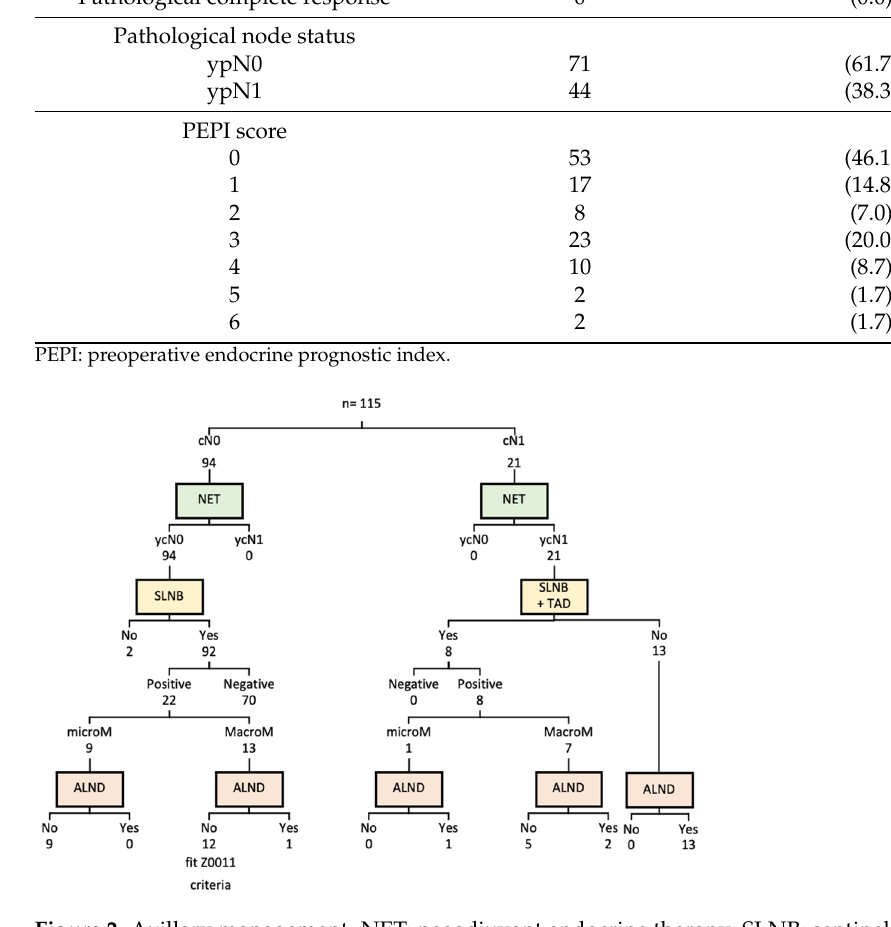
Figure 2. Axillary management. NET: neoadjuvant endocrine therapy; SLNB: sentinel lymph node biopsy; TAD: targeted axillary dissection; ALND: axillary lymph node dissection.